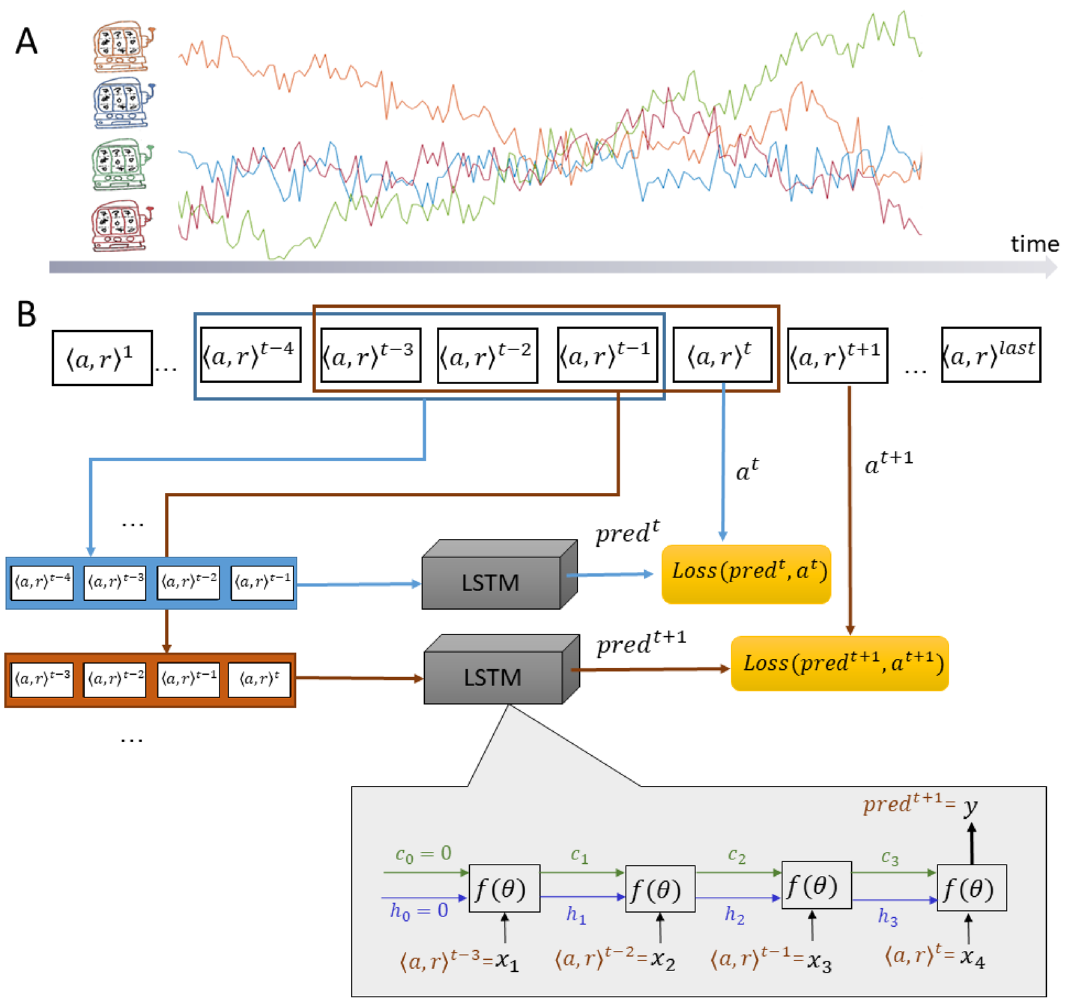
Figure 1. Experimental design and the exploratory LSTM model. ( A ) Experimental design—participants are asked to choose one of four options to gain rewards. The rewards associated with each option change slowly over time. ( B ) Sequences of four consecutive actions and rewards were used to train an LSTM model to predict the fifth action taken by the